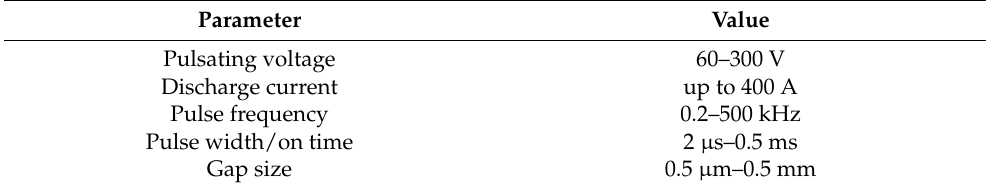
Table 1. Characteristic EDM parameter